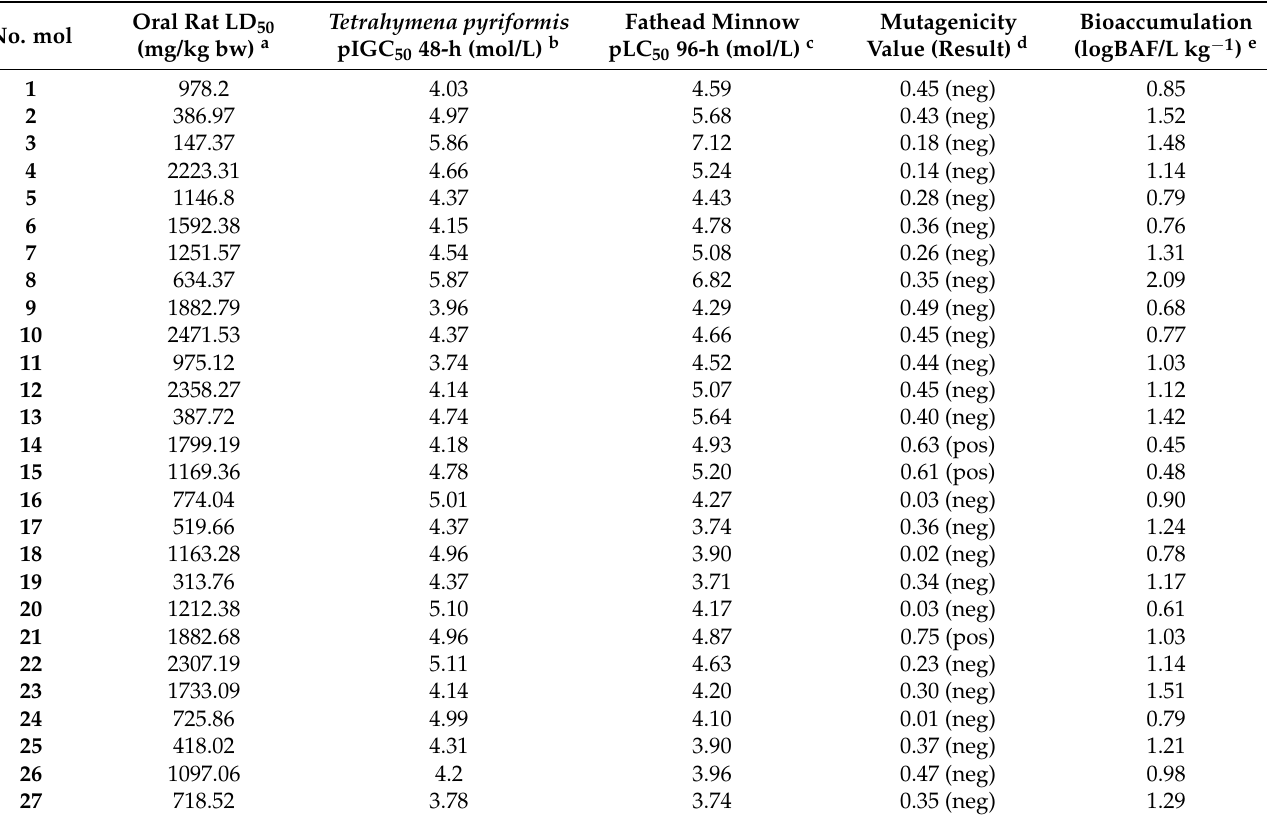
Table 3. Estimated toxicity for 38 coumarin